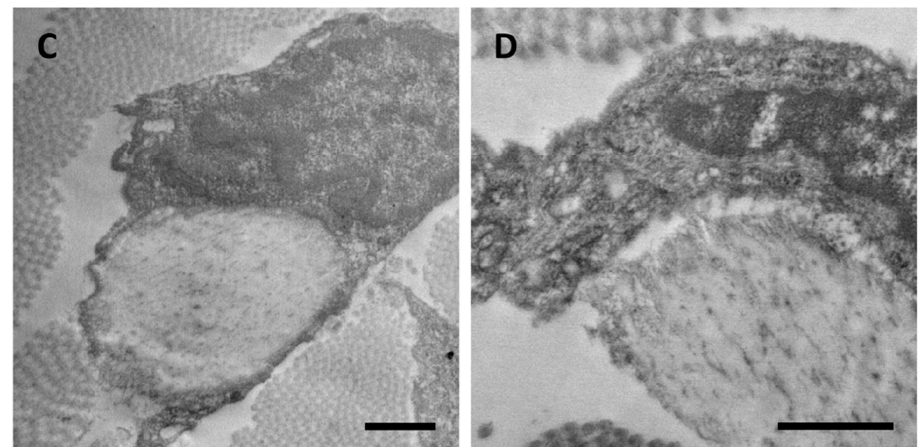
Figure 4. Representative electron microscopy images obtained from clinically affected skin of an eight-year-old child. ( A , B ) Filamentous microfibrillar material at the periphery of the elastic fibers and round electron-translucent structures within elastic fibers (arrows), were observed. ( C , D ) Fibroblasts embrace and/or are in close contact with elastic fibers. Scale bar = 1 µm.